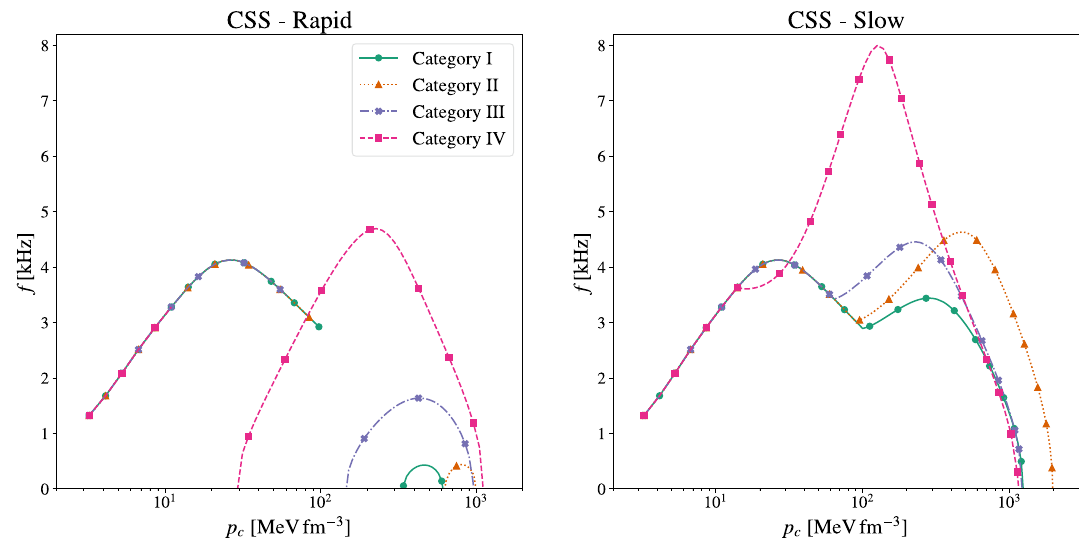
Fig. 1 Predictions for the fundamental linear eigenfrequency as a function of central pressure for neutral twin stars, considering rapid (left panel) and slow (right panel) conversions, considering the Categories I to IV of the CSS parametrization for the QM EoS